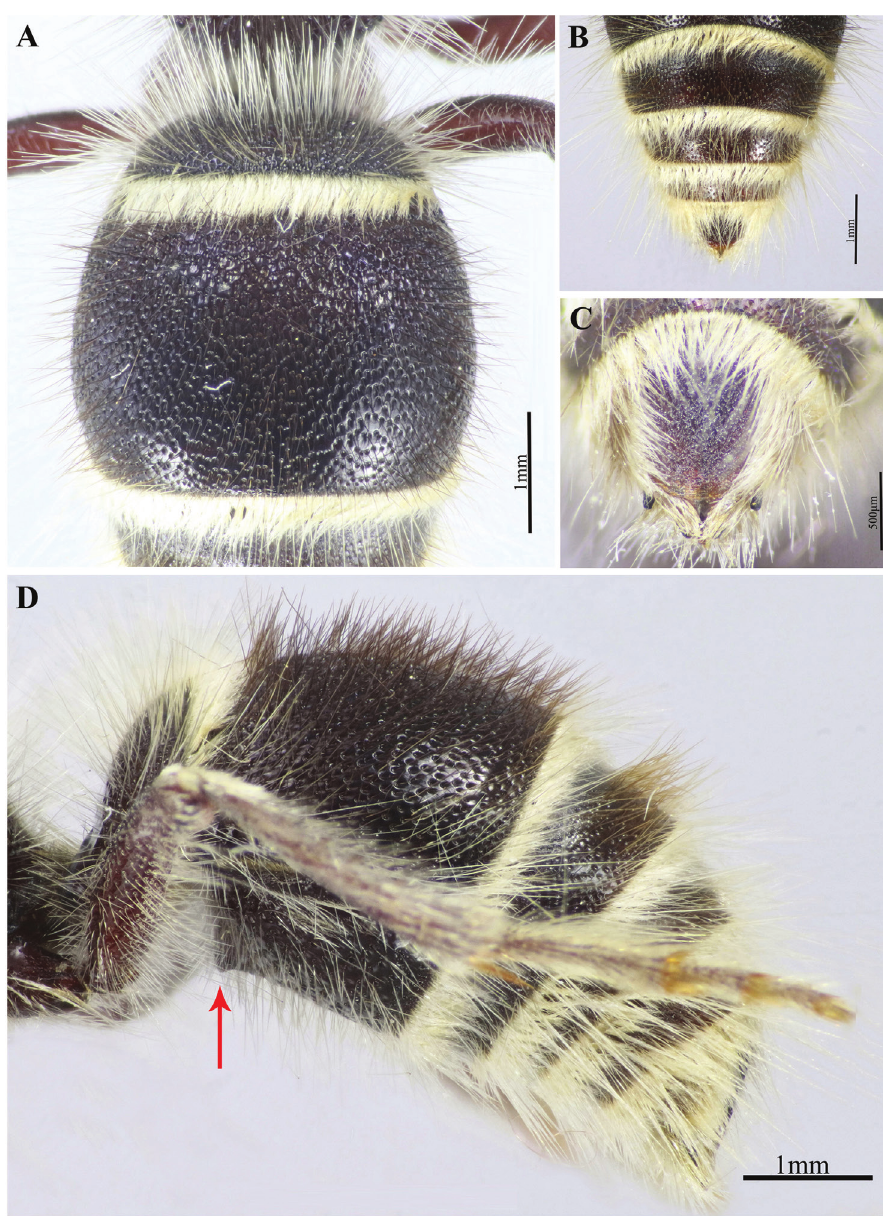
Figure 28. Pseudophotopsis maura Bischoff (Female) A T1 and T2, dorsal view B T3–T6, dorsal view C T6 (showing pygidial area) D metasoma, lateral view (median basal tubercle on S2